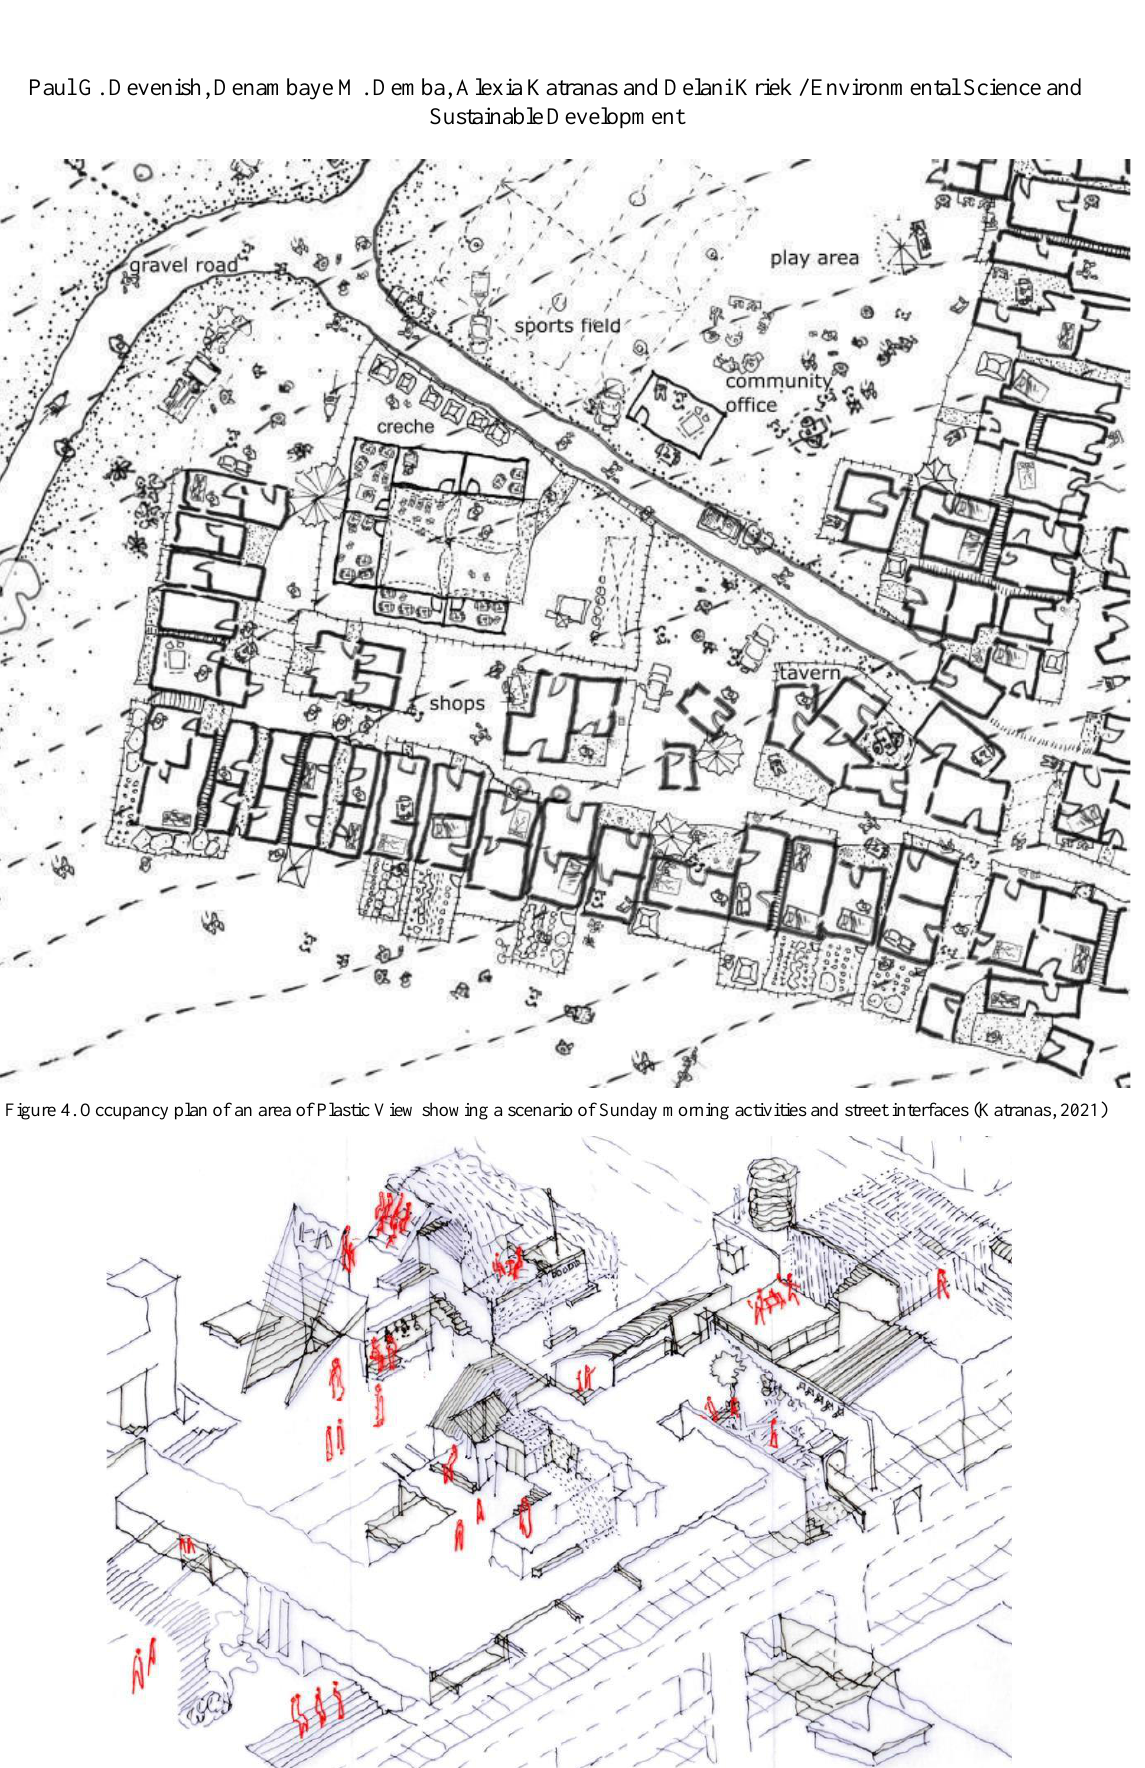
Figure 5. Illustration of design iterations exploring the connection of divisive urban infrastructure - hypothetical future scenarios based on field observations of building practices in Plastic View (Katranas,